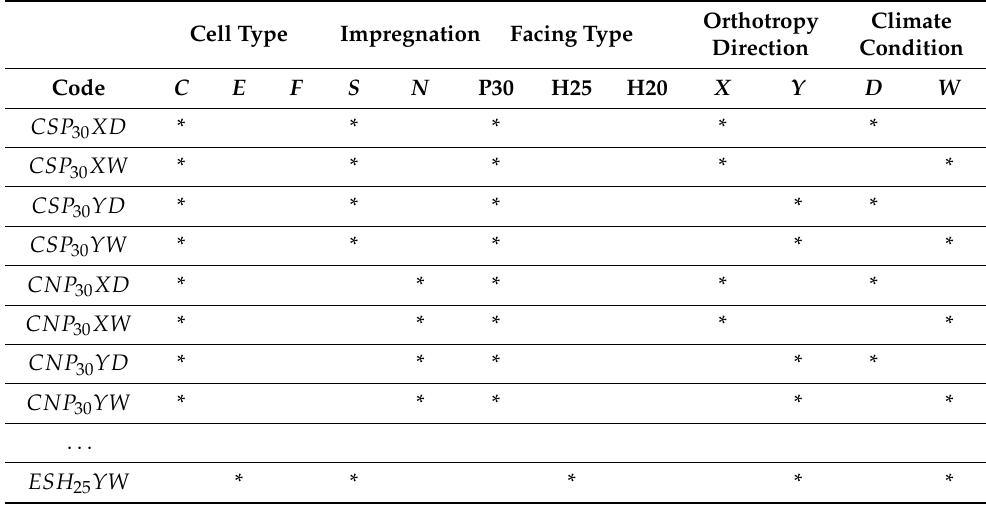
Figure 4. Test stand.